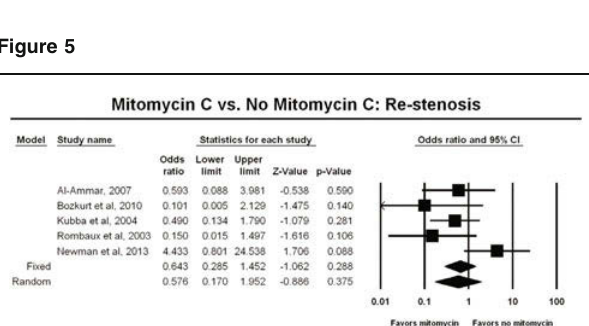
Funnel plot of the log risk ratio and the SE of risk ratio for determina- tion of publication bias.